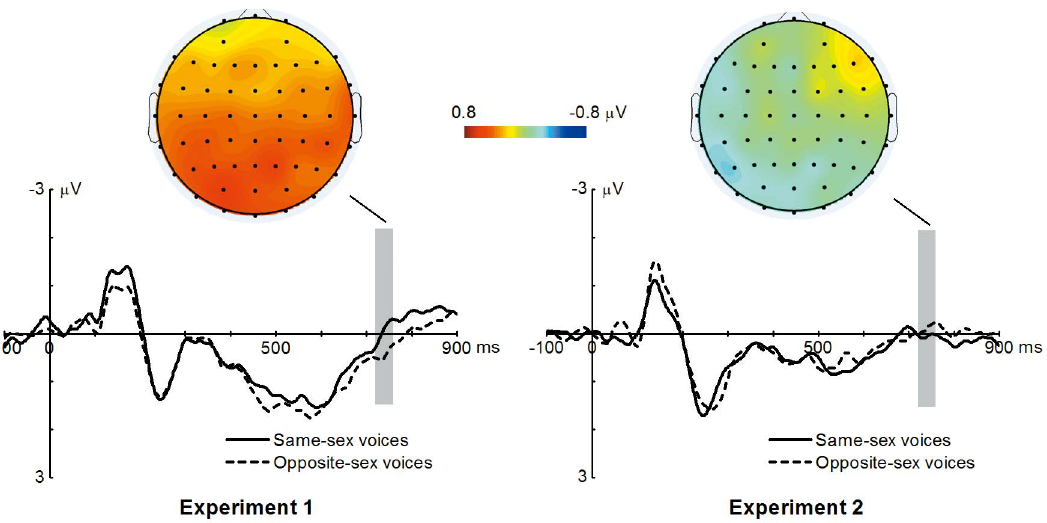
Figure 3. Grand-averaged ERP to opposite-sex voices and that to same-sex voices at electrode site PO3. In Experiment 1, the ERP to opposite-sex voices is positively deflected than that to same-sex voices at parieto-occipital recording sites (cluster p value=0.014). In Experiment 2, there is no significant difference between the ERP to same-sex voices and that to opposite-sex voices. Gray bars represent the time-window (720– 760 ms) centered on the peak of the difference between the ERP to same-sex voices and that to opposite-sex voices in Experiment 1. The topographies illustrate the difference between the ERP to same-sex voices and that to opposite-sex voices at the time-window (720–760 ms).